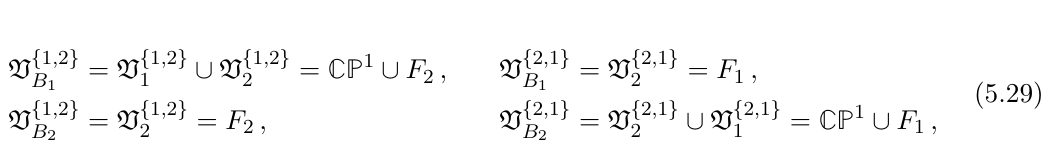
Figure 14. The support of thimble boundary conditions generated by vacua v tations (cid:25) = 1 ; 2 ( m 3 < 0) and (cid:25) = f g